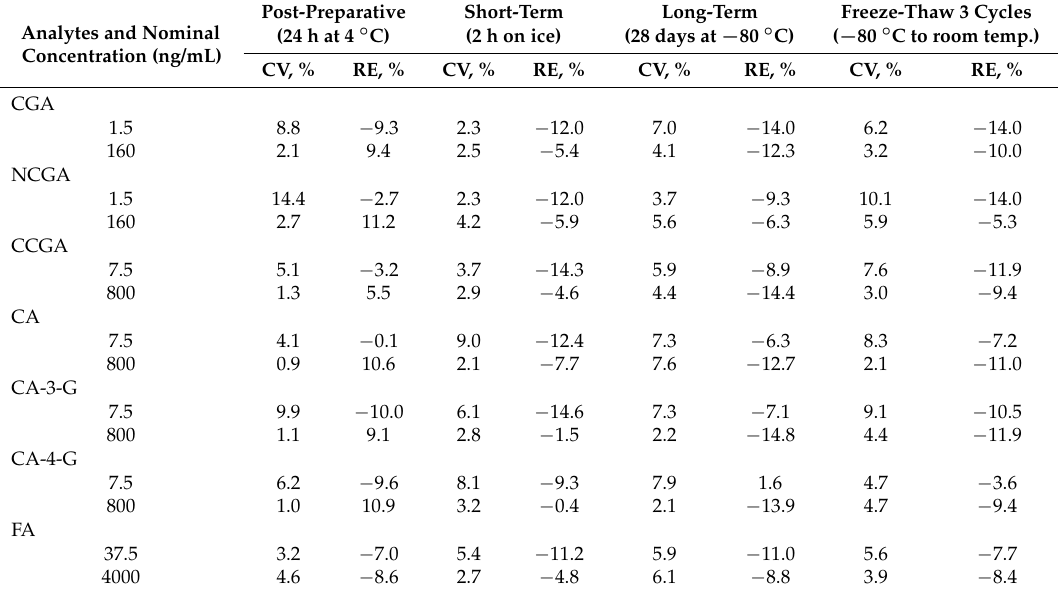
Table 3. Post-preparation, short-term, long-term and freeze-thaw stabilities of CGA, NCGA, CCGA, CA, CA-3-G, CA-4-G, and FA in rat plasma quality control samples ( n = 3). Post-Preparative Short-Term Long-Term Freeze-Thaw 3 Cycles Analytes and Nominal (24 h at 4 ◦ C) (2 h on ice) (28 days at − 80 ◦ C) ( − 80 ◦ C to room temp.) Concentration (ng/mL) CV, % RE, % CV, % RE, % CV, % RE, % CV, % RE, % CGA 1.5